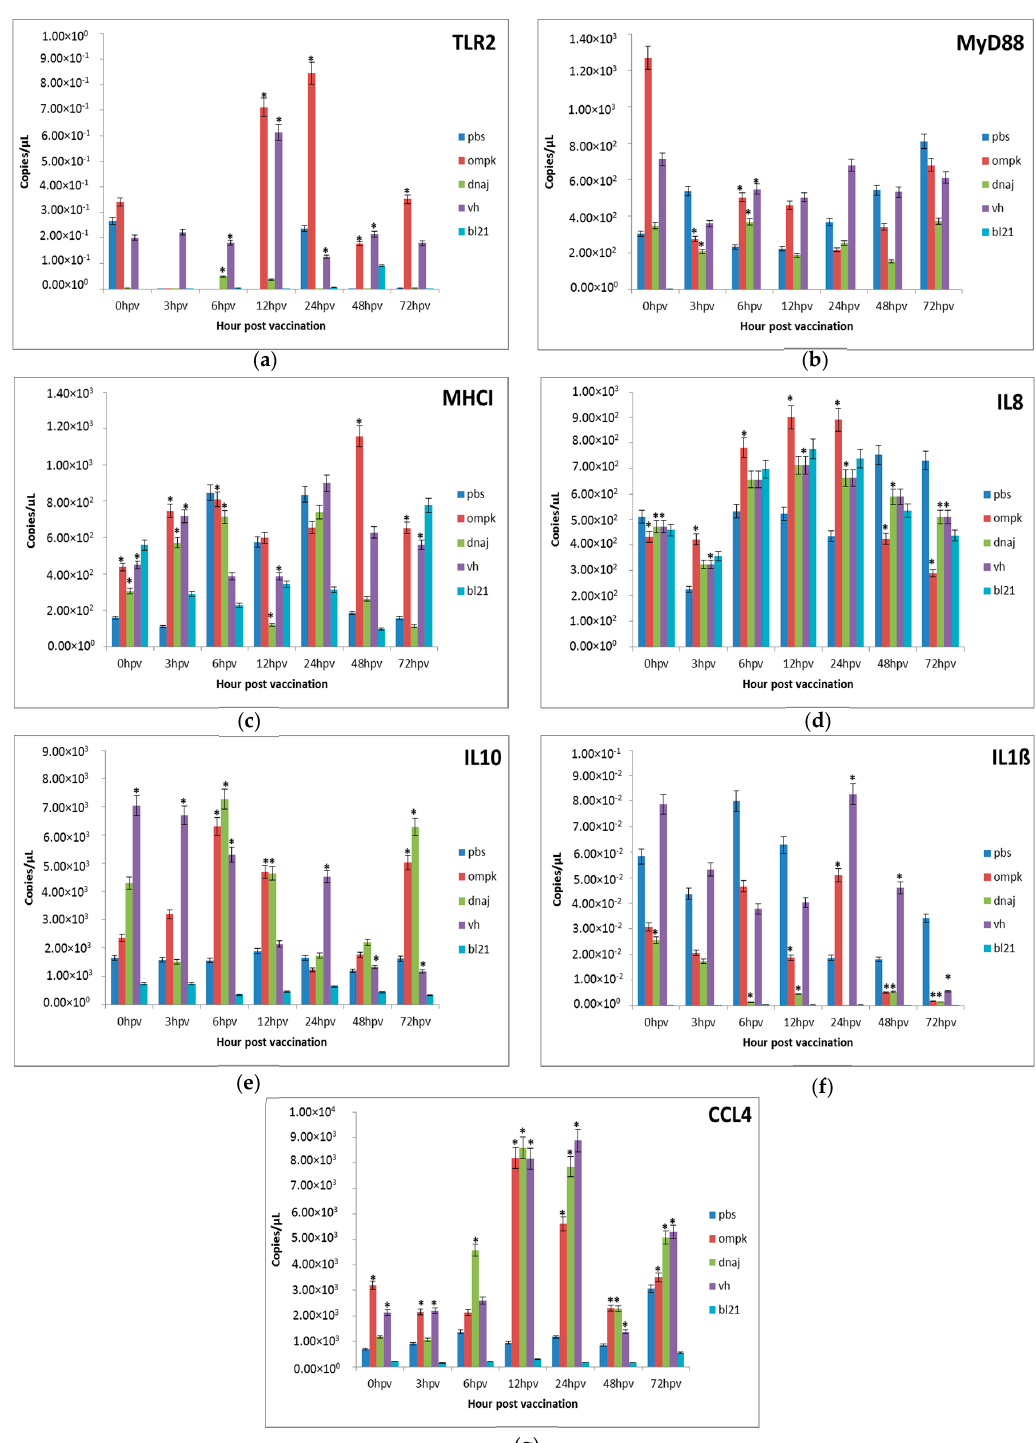
Figure 3. Comparative expression profiles of the antigen recognition-related genes ( a ) TLR2, ( b ) MyD88, ( c ) MHCI and pro-inflammatory cytokines ( d ) IL8, ( e ) IL10, ( f ) IL1ß, ( g ) CCL4 in the kidney of juvenile seabass after vaccination. Juvenile seabass were injected with 10 7 CFU / mL of the inactivated pET-32 / LIC- OmpK and pET-32 / LIC- DnaJ recombinant cell, inactivated E. coli BL21 (DE3) and formalin-killed whole cell V. harveyi vaccines, while the unvaccinated control group was injected with PBS solution. Bars represent the mean copy number of three biological replicates and error bars represent standard deviation. Statistical significance was analyzed between the vaccinated and PBS control groups of seabass (* p <